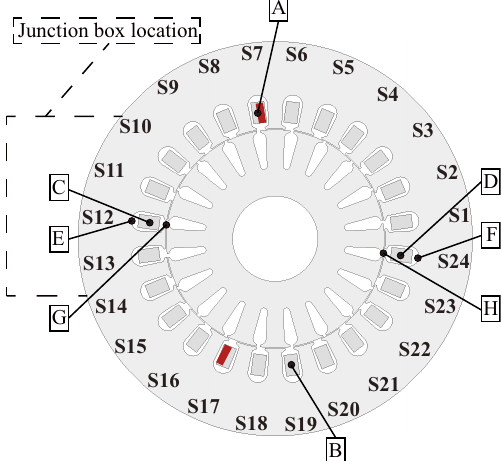
Figure 3. Cross section of the prototype and internal TMP